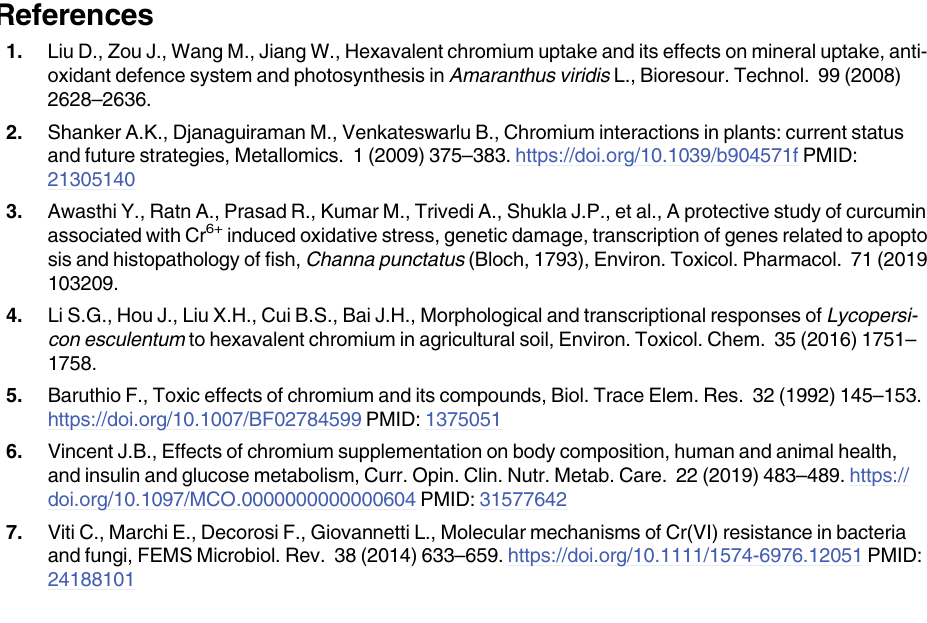
S1 Table. Differentially expressed genes under Cr(VI) stress in strain